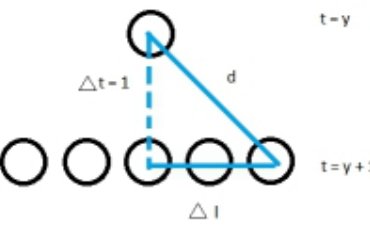
Figure 2. Illustration of distance in game tree